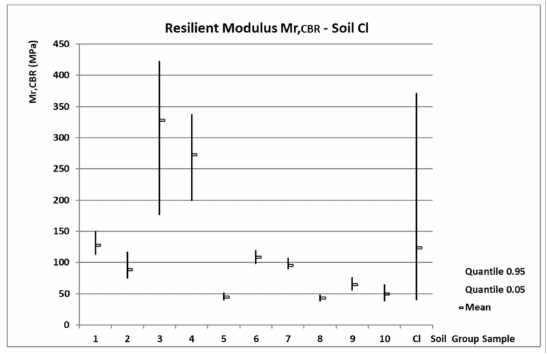
Figure 1. Statistical quantities—mean, 0.05 quantile, 0.95 quantile of M r,CBR for Cl